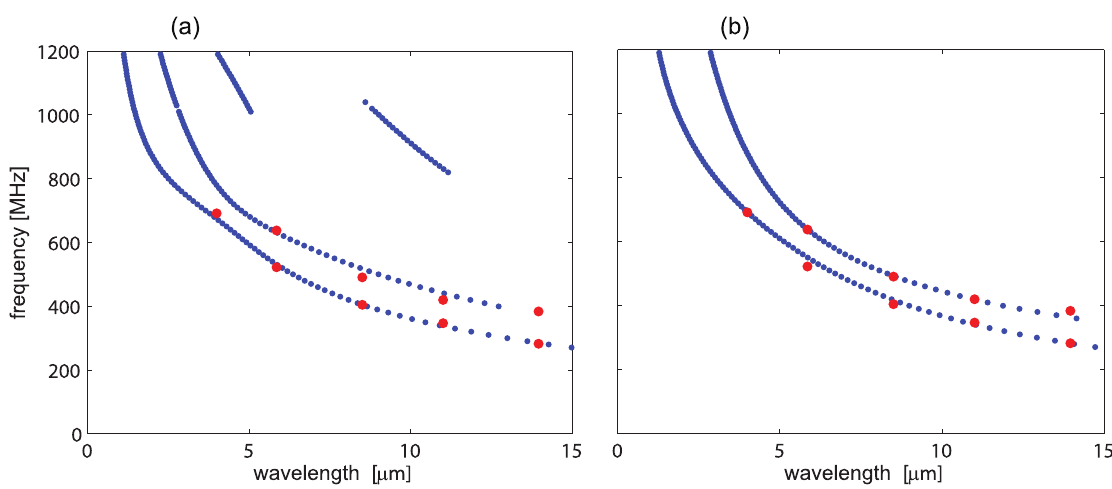
Figure 10. Dispersion curves calculated for the sample shown in Figure 2 within ( a ) M = 3 and ( b ) M = 4 models with the effective parameters from Table 3.